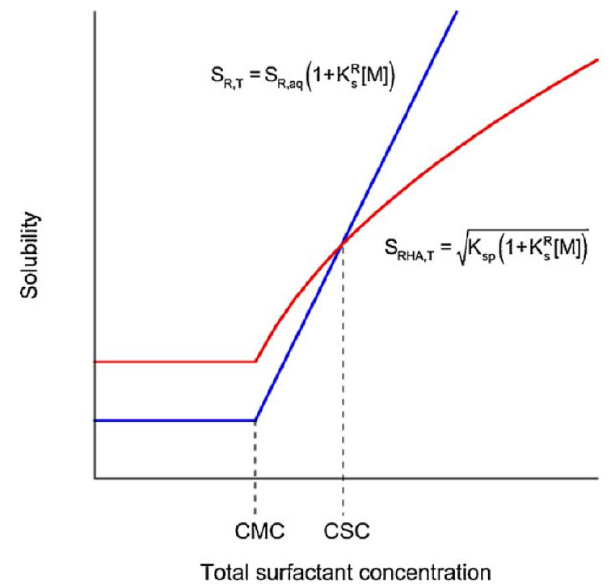
Figure 36. Determination of Critical Stabilization Concentration from the total surfactant concentration [Reprinted from [314] with permission from Elsevier].